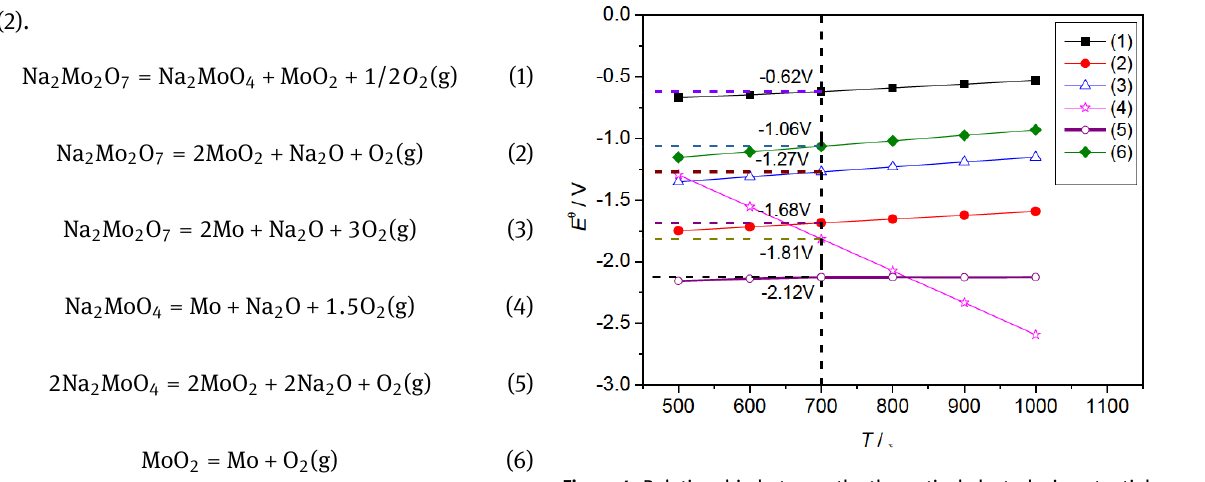
Figure 5(a) were cyclic voltammetry curves at differ- ent sweep speeds. The peak current gradually increased with the scanning speed increases, which was because the higher the scanning speed, the higher the electrochemical